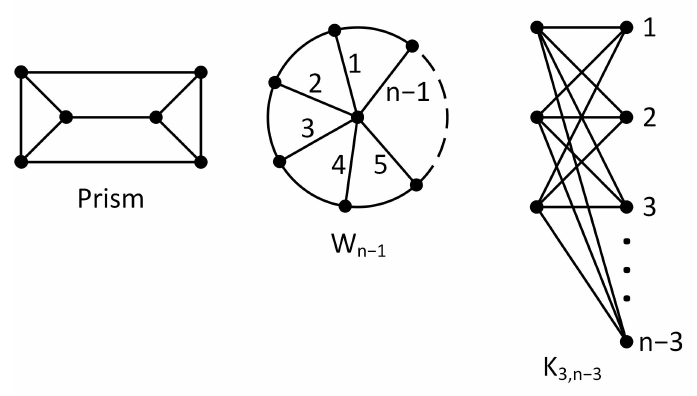
Figure 1. The prism graph, W n − 1 for n ≥ 4, and K 3, n − 3 for n ≥